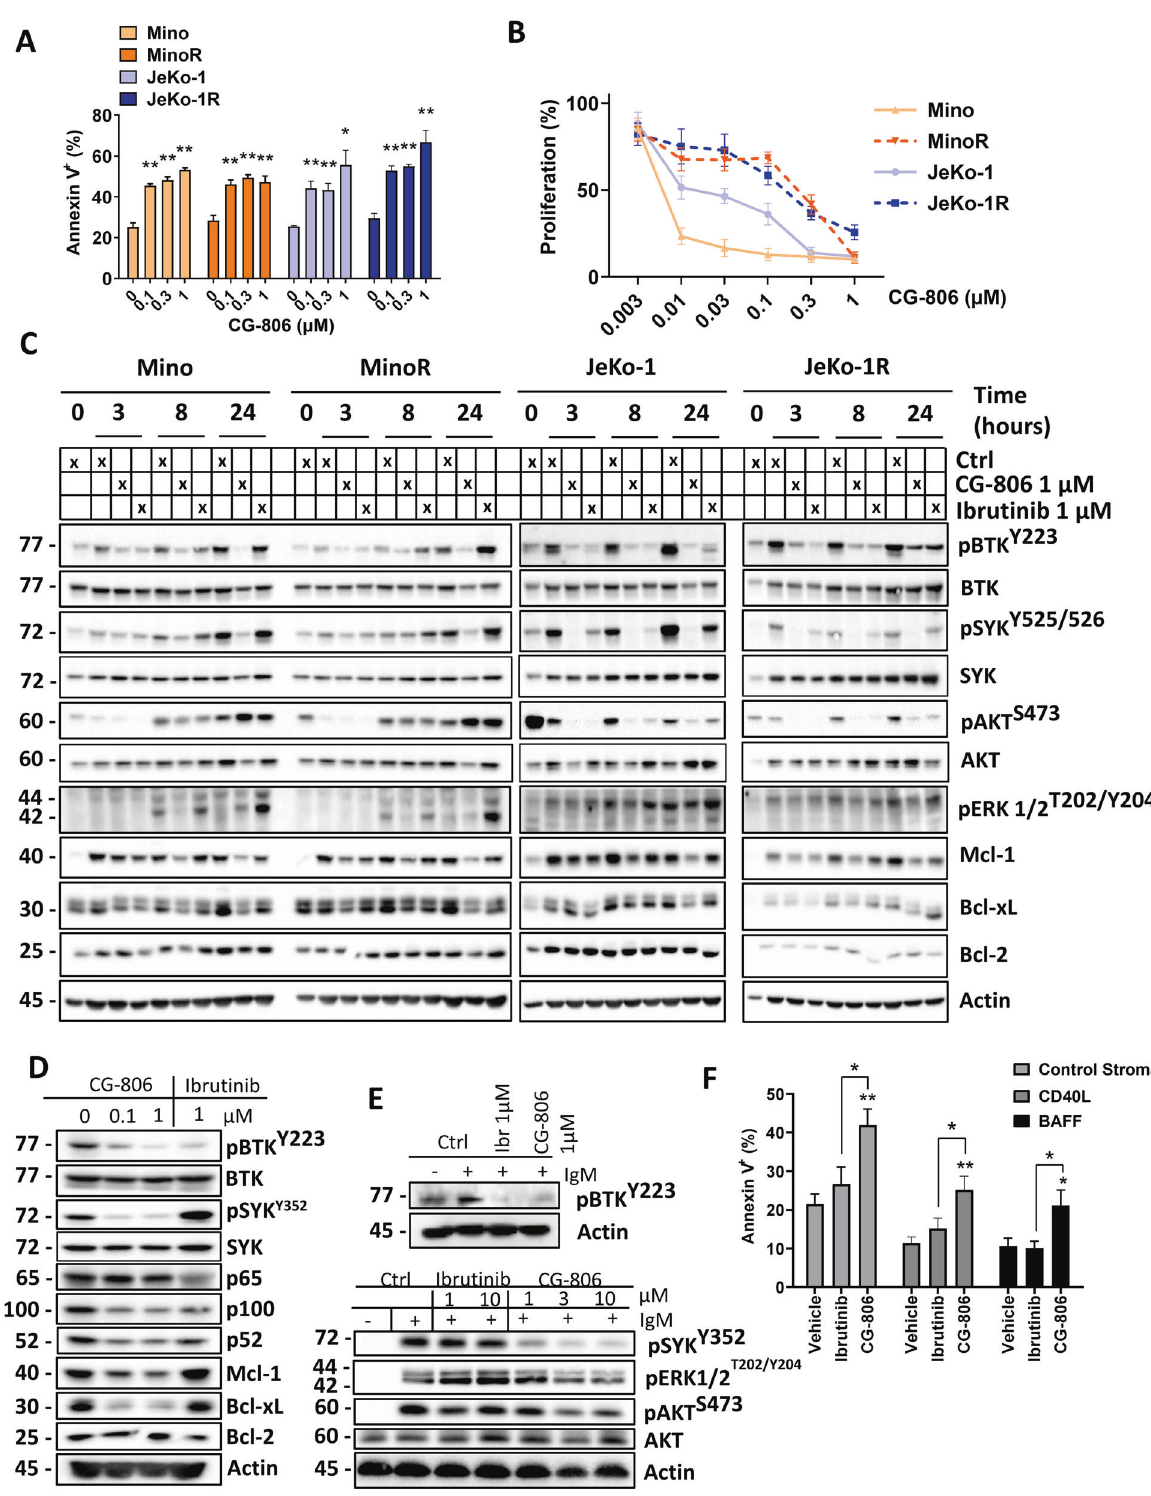
Fig. 1 CG-806 induces apoptosis and attenuates B-cell receptor signaling in MCL. A Cells were treated with indicated doses of CG-806 for 24 h. Apoptosis was determined by Annexin-V-FITC staining. Data are shown as mean ± SEM. B Parental and ibrutinib-resistant MCL cell lines were treated with the indicated doses of CG-806 for 48 h. Cell proliferation was assessed using a colorimetric tetrazolium-based assay. Mean ± SEM is shown. C Cells were treated with drugs as indicated. Cell lysates were subjected to immunoblotting. D Mino cells were treated with the indicated concentrations of drugs for 24 h. E Primary MCL cells (from three individual patients) were treated with vehicle control, ibrutinib or CG-806 for 1 h, then were stimulated with 5 µg/mL IgM for 30 min. Whole-cell lysates were analyzed using immunoblotting. Representative blots are shown. F Primary MCL cells ( n = 5 individual samples tested in technical duplicates) were co-cultured with stroma for 24 h. Cells were then treated with 1 µM CG-806 or ibrutinib for 48 h. Apoptosis of the CD19 + B-cell population was quanti fi ed using Annexin-V staining. * p < 0.05 and ** p < 0.01 vs. untreated